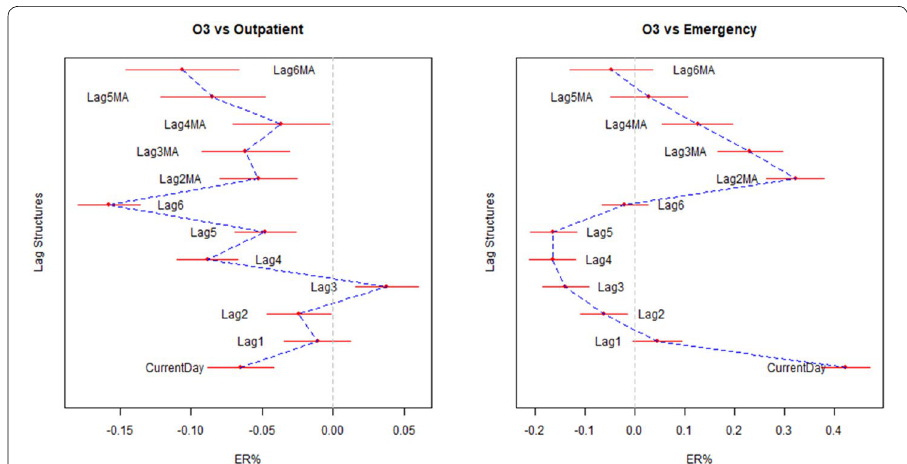
Fig. 6 Percent increase (excess risk, ER) with different lag structures for total pediatric outpatient and emergency admissions (three hospitals) owing to ozone (O 3 ) concentration. ER for every unit (10 μg/m 3 ) increase in O 3 concentration. ER values obtained by single‑pollutant regression. The X‑axis represents ER values, and the Y‑axis is different lag structures. Red bars indicate 95% confidence intervals of ER. Lag1 to Lag6 are simple lag effects and Lag2MA to Lag6MA are 2‑day to 6‑day cumulative effects